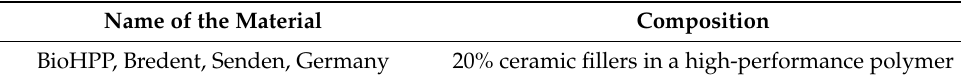
Table 1. The composition of the studied material. Name of the Material